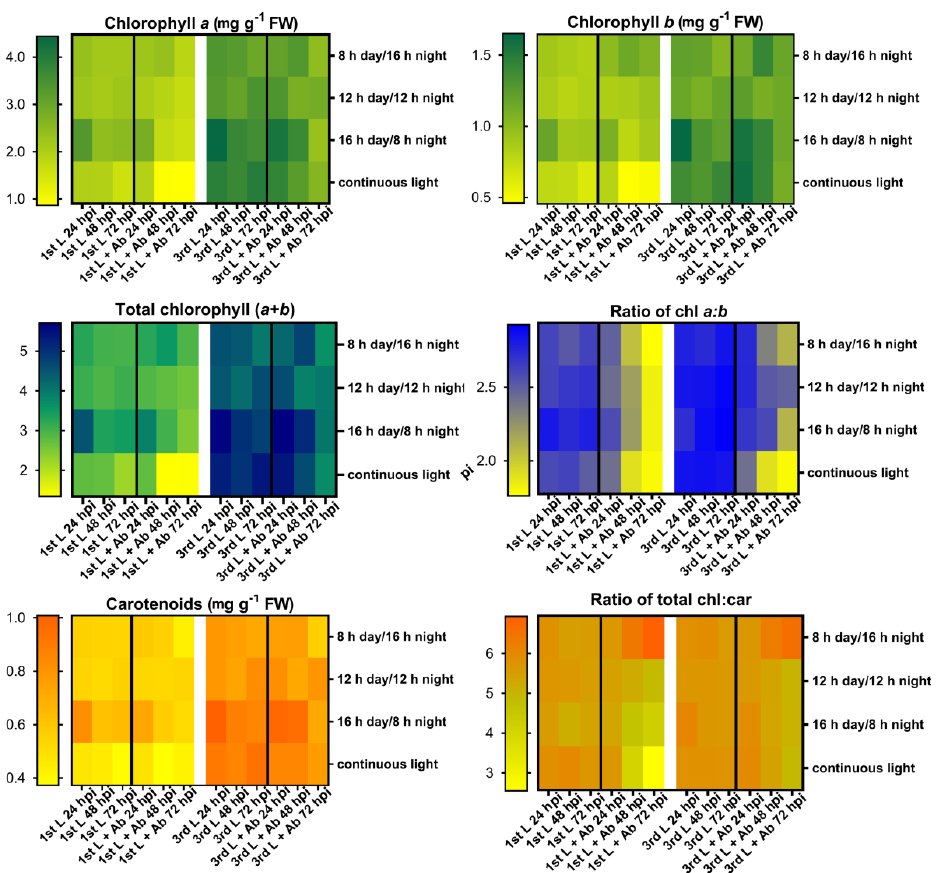
Figure 4. Heatmaps based on the mean values of chlorophylls and carotenoids contents in the 1st and 3rd leaf of B. juncea plants during the progress of A. brassicicola infection. The experiment was performed in plants grown under different day-length regimes and was independently repeated four times ( n = 4). Details of the statistical analysis of the parameters are shown in the Supplementary Material Tables S1 and S2, and Figure S2. Abbreviations: 1st L, first leaf; 3rd L, third leaf; Ab, A. brassicicola ; car, carotenoids; chl, chlorophyll; FW, fresh weight.